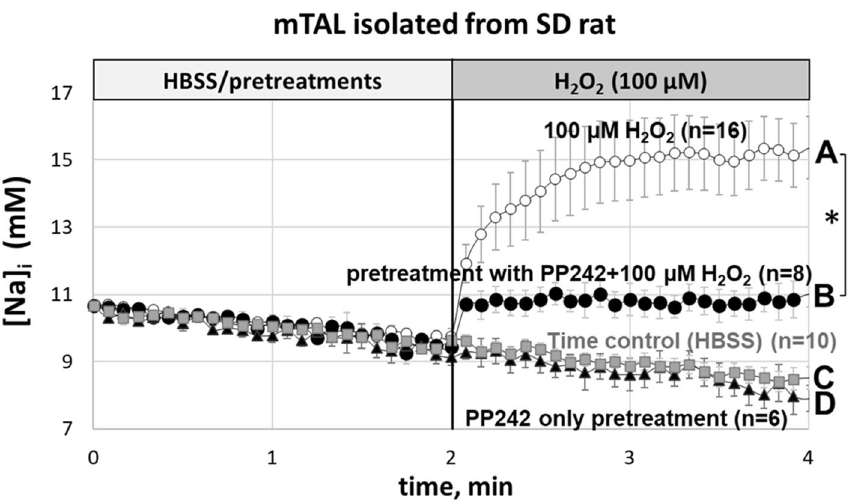
Figure 3. Intracellular [Na + ] i responses in isolated mTAL determined using Na + sensitive dye, Na Green. ( A ) Responses to 100 µM of H 2 O 2 (open circles; shown as A on the right; n = 16); ( B ) Responses after pretreatment of mTAL with 10 µM PP242 in HBSS bath for 10 min followed by addition of final 100 µM of H 2 O 2 concentration (black circles; shown as B on the right; n = 8); ( C ) Time control recording in HBSS medium (gray squares; shown as C on the right; n = 10); ( D ) Pretreatment of mTAL with 10 µM PP242 in HBSS bath for 10 min and throughout all measurements (black triangles; shown as D on the right; n = 6). * P < 0.05 between mTAL treated with H 2 O 2 compared to those pretreated with PP242; determined by Student’s